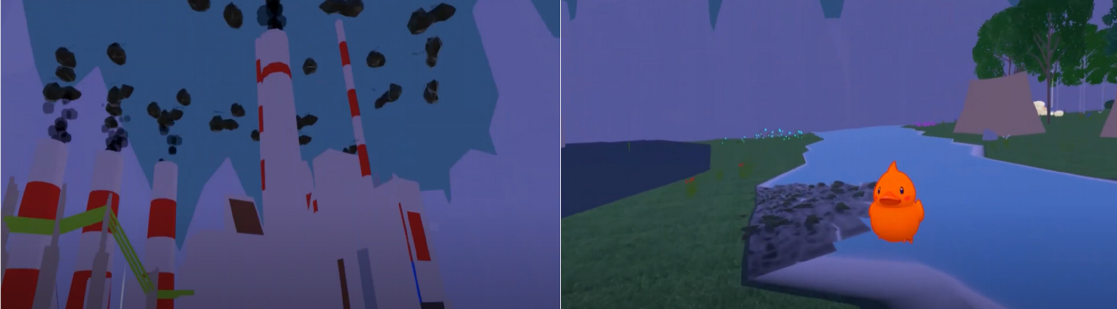
Figure 8. Cleaning air pollution (left) and purifying water pollution in the stream (right).